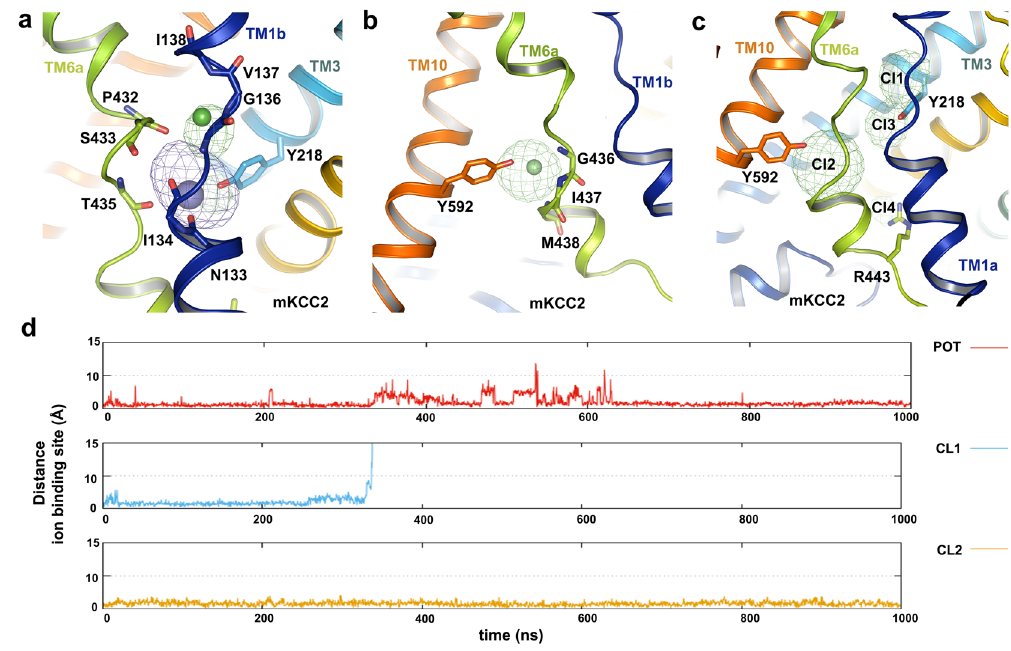
Fig. 5 Ion-binding probability densities of mKCC2. a K + and Cl − (Cl − -1) binding sites of mKCC2 based on molecular dynamic simulations. Similar to hNKCC1, K + is stabilized by the interaction with Y218 in TM3, N133 and I134 in TM1a, T435 and P432 in TM6, and the Cl − ion. The Cl − binding site is stabilized by interaction with G136, V137, and I138 in TM1 and by the K + ion. b A second Cl − binding site (Cl − -2) of mKCC2. Similar to (Cl − -2) in hNKCC1, this Cl − is stabilized by the interaction with G436, I437, and M438 in TM6, and Y592 in TM10. c Four Cl − ion probability densities in mKCC2 based